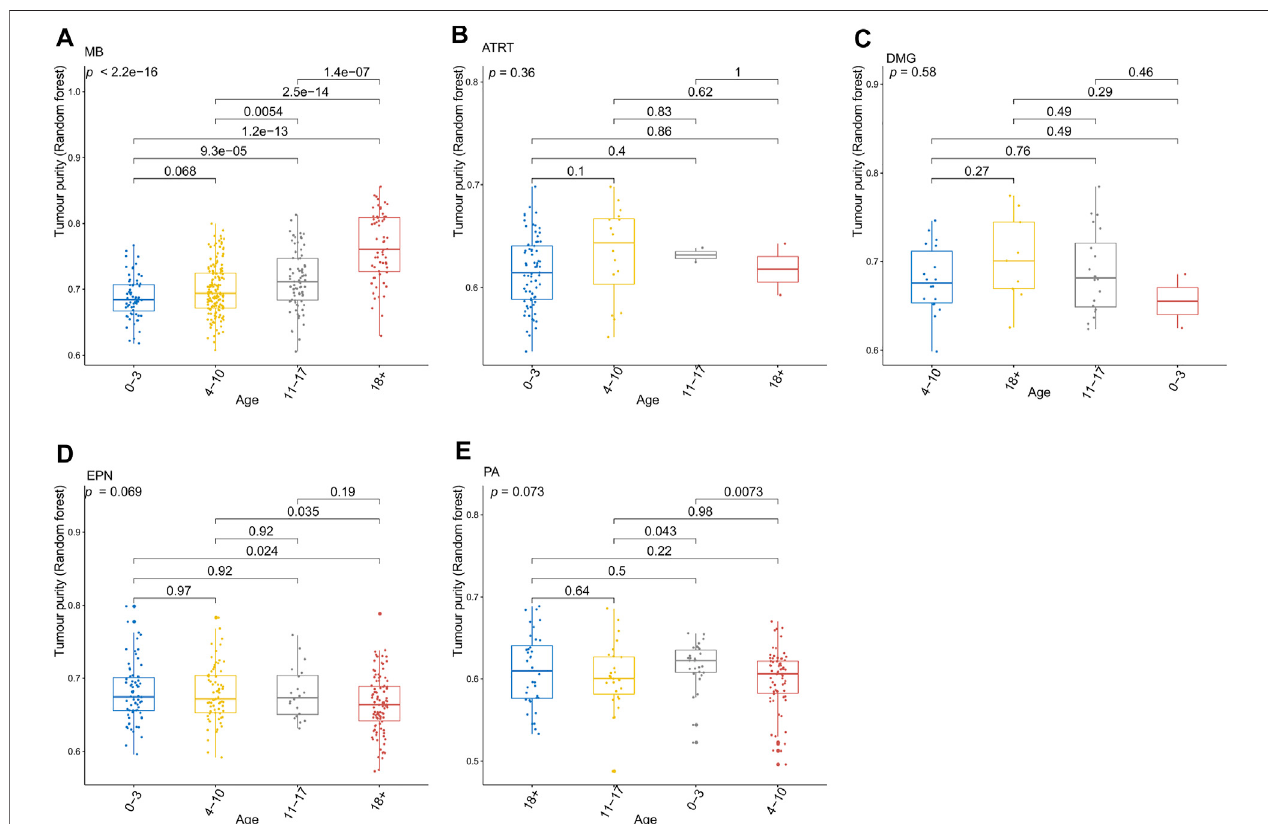
FIGURE3| RelationshipbetweenthetumorpurityofeachpediatricCNStumorandthepatientageatdiagnosisintheGSE90496dataset. (A) Boxplotofthetumor purityinmedulloblastoma(MB)samplesbytheageatdiagnosis; (B) boxplotofthetumorpurityinatypicalteratoma/rhabdoidtumorsamplesbytheageatdiagnosis; (C) box plot of the tumor purity in diffuse midline glioma samples by the age at diagnosis; (D) box plot of the tumor purity in ependymoma (EPN) samples by the age at diagnosis; (E) box plot of the tumor purity in pilocytic astrocytoma samples by the age at diagnosis.